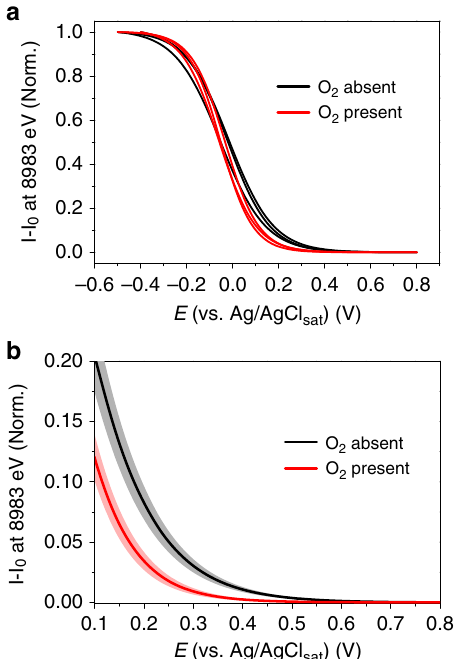
Fig. 4 Cu + potentiometric response in catalytic and non-catalytic conditions. a Cu K-edge potentiometric curves of Cu + signal at 8983 eV (black line) in argon-saturated electrolyte and (red line) in oxygen- saturated electrolyte. b Highlighted region of the averaged curves in each condition where the rise in the signal at different overpotential values shows the shift between the curves (shades represent the standard deviation).